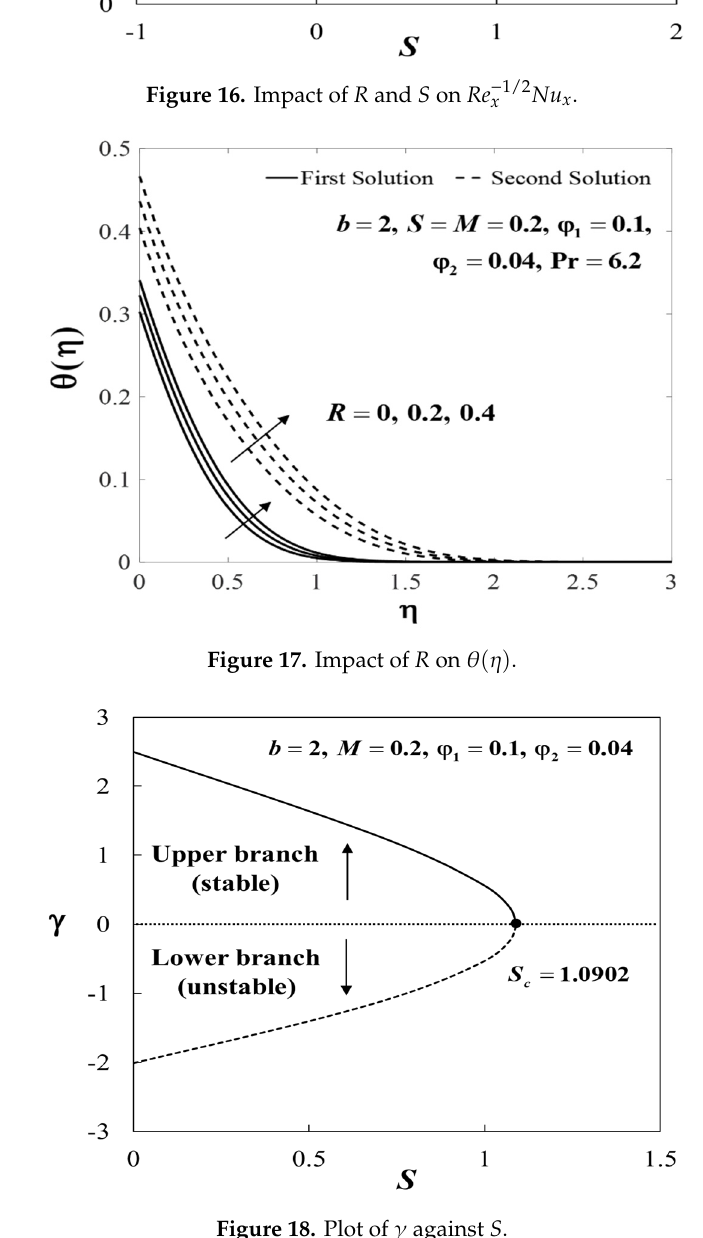
Figure 18. Plot of 𝛾 against 𝑆 .